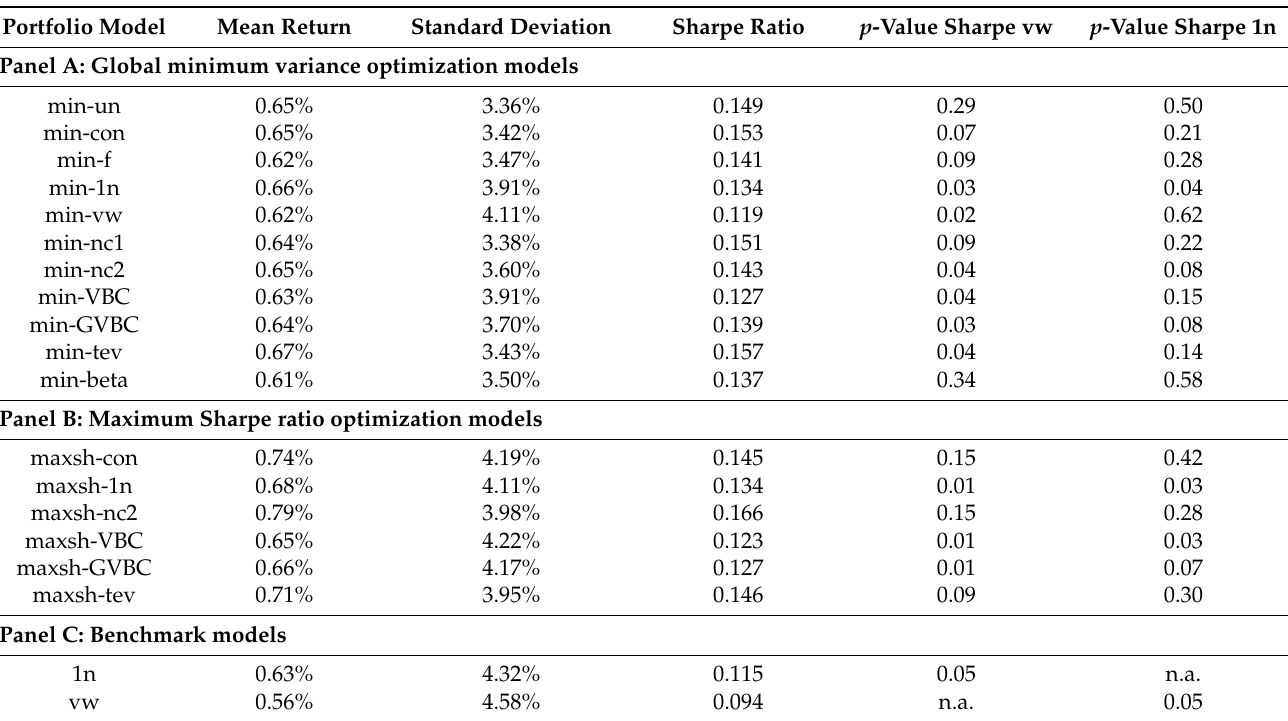
Table 3. Sharpe ratios of